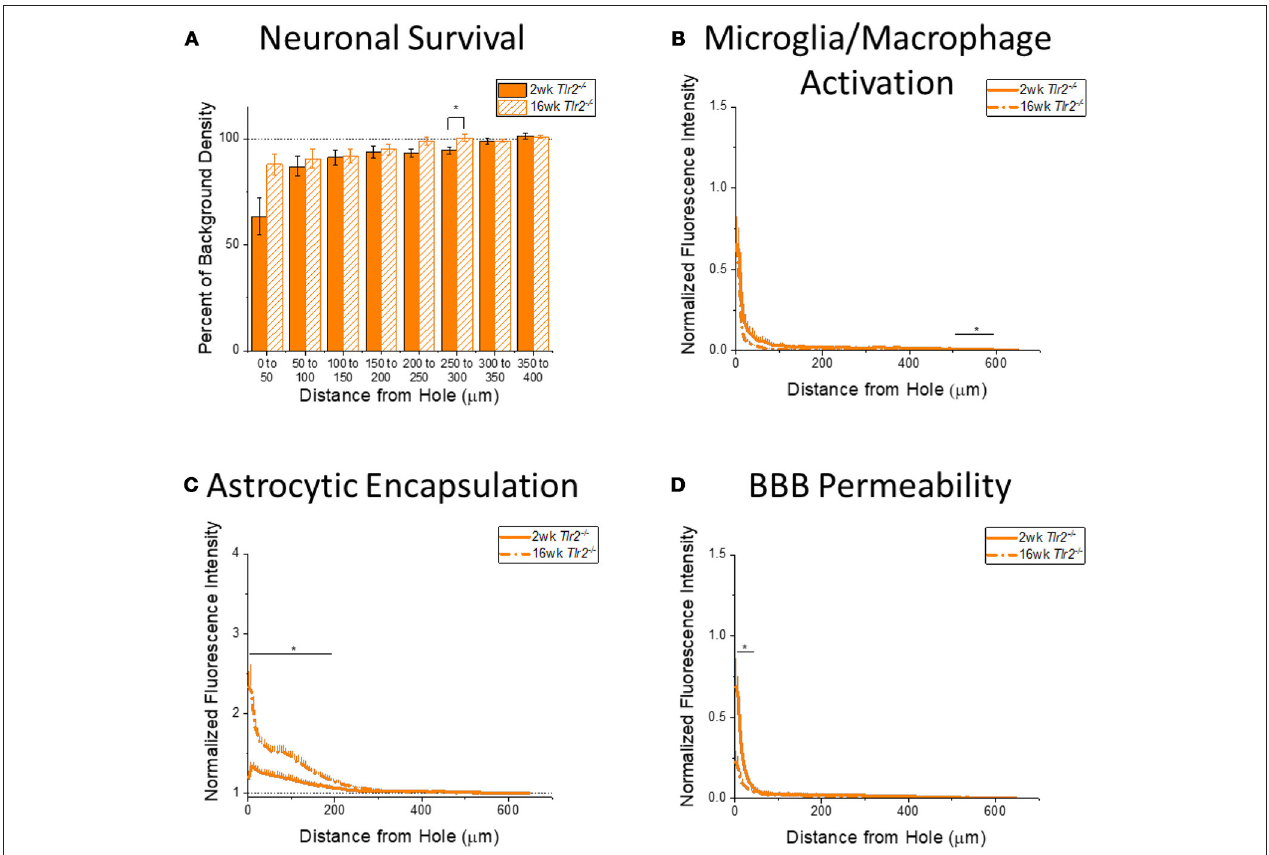
FIGURE 5 | Changes in immunohistochemical markers in Tlr2 − / − mice over time. (A–D) Show immunohistochemical marker expression in Tlr2 − / − mice at 2 and 16 weeks after probe implantation. (A) Neuronal survival displayed as percent of background neuronal density with respect to distance from the probe hole ( µ m). Tlr2 − / − mice exhibit significantly higher neuronal survival at 16 weeks after probe implantation in the distance interval 250–300 µ m from the probe hole. 2 wk Tlr2 − / − : N = 7; 16 wk Tlr2 − / − : N = 5. (B) Microglia and macrophage activation (CD68) displayed as normalized fluorescence intensity with respect to distance from the probe hole ( µ m). Tlr2 − / − mice exhibit significantly higher microglia and macrophage activation at 2 weeks after probe implantation at the distance interval 550–600 µ m from the probe hole * p < 0.05. 2 wk Tlr2 − / − : N = 8; 16 wk Tlr2 − / − : N = 5. (C) Astrocytic encapsulation (GFAP) displayed as normalized fluorescence intensity with respect